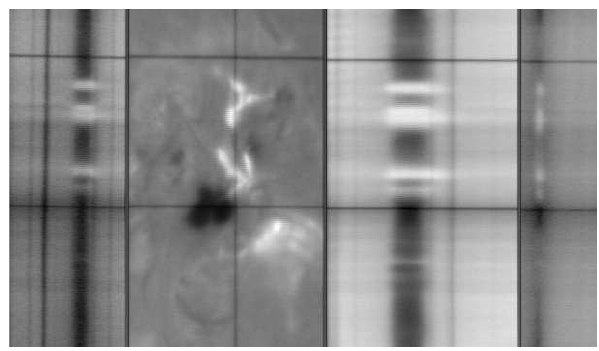
Fig. 2. The MFS observation of the flare kernels 1 and 2 taken at 09:56:30UT when the first X-ray peak was observed. The image is composed of H β , H α , and the infrared CaII spectrograms and H α filtergram (the second section from the left, where North is up and West to the right). Notice that the H α emission profiles were still rather narrow.